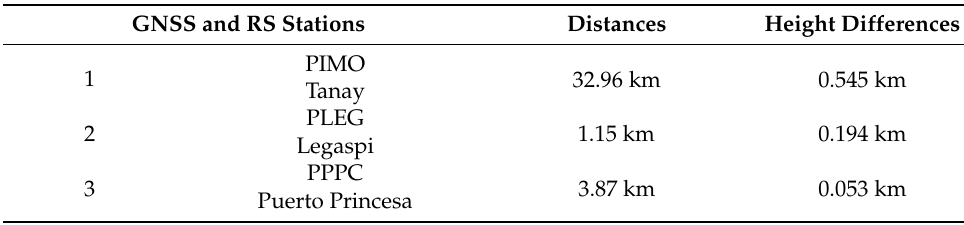
Table 1. The distances of the GNSS stations to their collocated RS stations selected in this study. Height differences between the stations are also